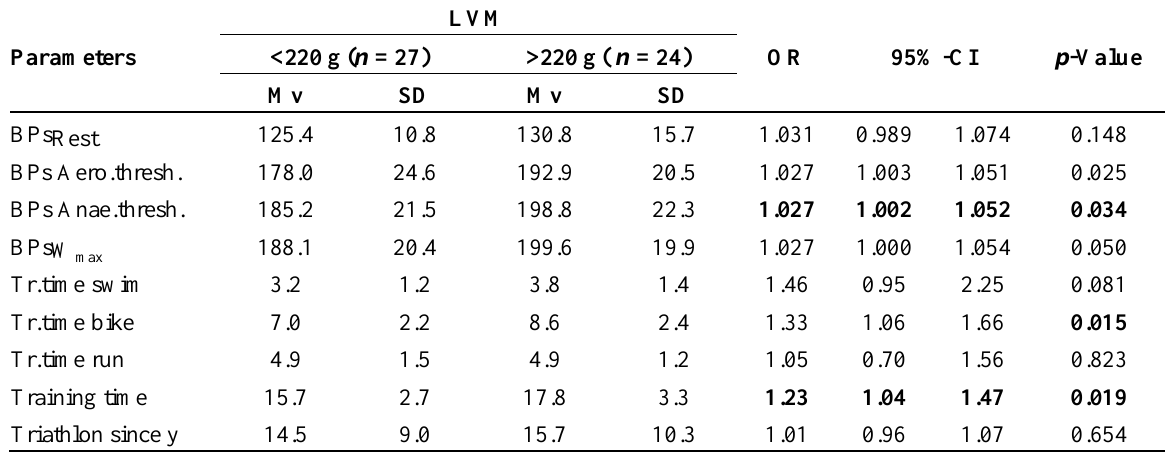
Table 8. Probability of LVM >220 g: odds